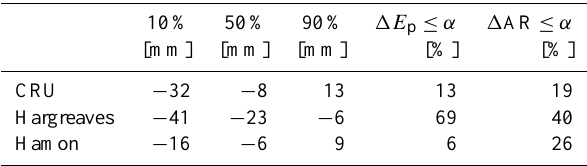
Fig. 3. Sensitivity coefficients of streamflow to precipitation as function of E T / P . Left panel: ε Q,P ; CCUW computed for the CCUW method. Dots represent ε Q,P ; CCUW using long-term av- erage data of the respective basin. Vertical grey lines depict the interquartile range of ε Q,P ; CCUW estimated for each year in the record, while light blue horizontal lines show the interquartile range for E T / P . Right panel: ε Q,P for different methods using long-term averages of ( P,E p ,Q ) of the period 1949–2003. Note that a loga- rithmic y-axis is used for both plots.